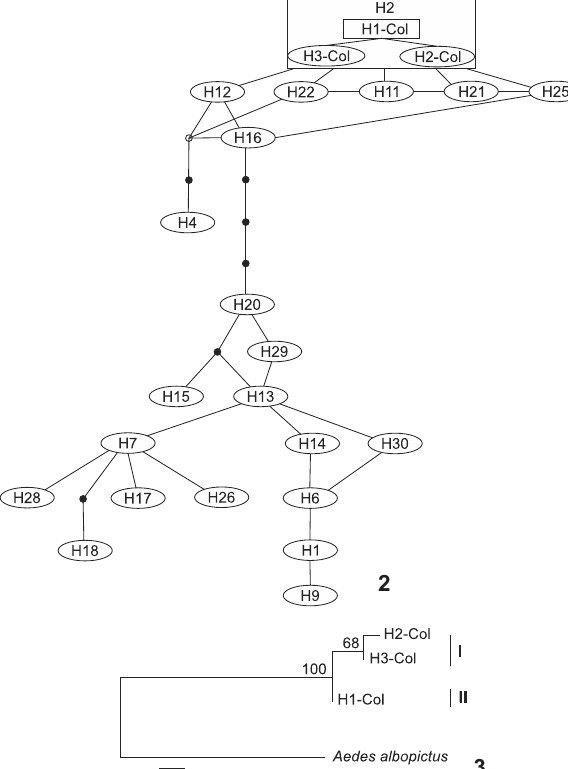
Figures 2-3. (2) Haplotype network among mitochondrial ND4 haplotypes. The rectangle represents the ancestral haplotype. Each black dot indicates a single substitution. The size of the circle is not proportional to the haplotype frequency. The numbers inside the circle indicate the Haplotype number. H1-H3-Col present study;